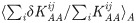
Analysis of changes in connectivity.A Top panel: relative changes in population-specific intrinsic indegrees summed over target populations and averaged across areas, 〈∑iδKAAij/∑iKAAij〉A. Bottom panel: changes in the indegrees within and between exemplary areas V4 and CITv relative to the total indegrees of the target populations, i.e., δKAAij/∑jKAAij. Populations ordered as in Fig 7C. B Pearson correlation coefficient of the changes of the internal indegrees δKAAij between all pairs of the 32 areas. Areas ordered according to hierarchical clustering using a farthest point algorithm [31]. The heights of the bars on top of the matrix indicate the architectural types of the areas (types 1 and 3 do not appear in the model) with color representing the respective clusters. C
FLN of the modified connectivity after 4 iterations versus the original FLN of the model. Only FLN>10−3 are shown for a better overview. The overlapping red dots represent the connections between areas 46 and FEF. Unity line shown in gray. D Histogram of the cumulative changes in SLN over all four iterations (δSLN=SLN(4)-SLN(0)).